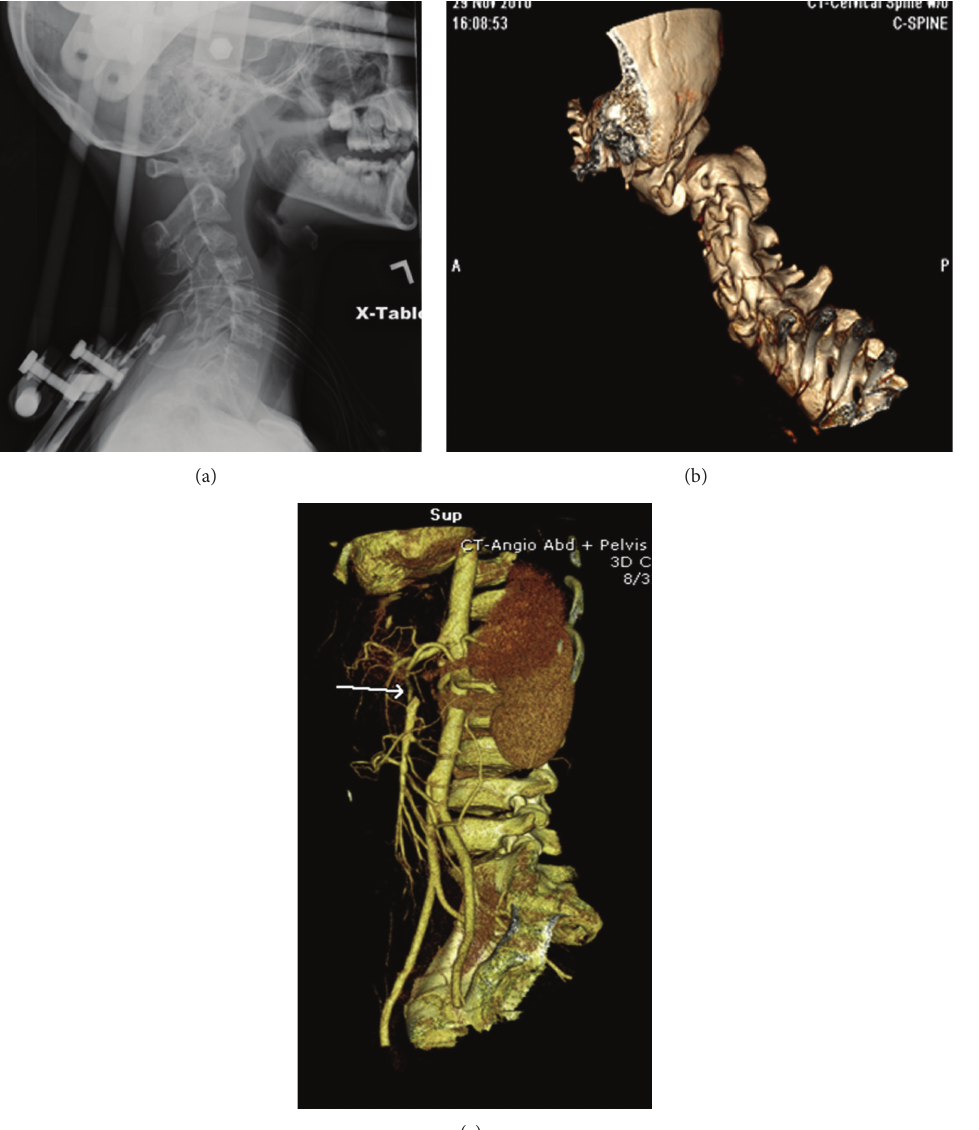
Figure 1: Lateral view (a) and 3D CT reconstruction (b) of the cervical spine of the patient. Note the severe posterior C1/C2 subluxation with posterior displacement of the C2 vertebral body in relation to C1. (c) 3D reconstruction from a CT angiogram for the patient, showing the filling defect of the inferior mesenteric artery